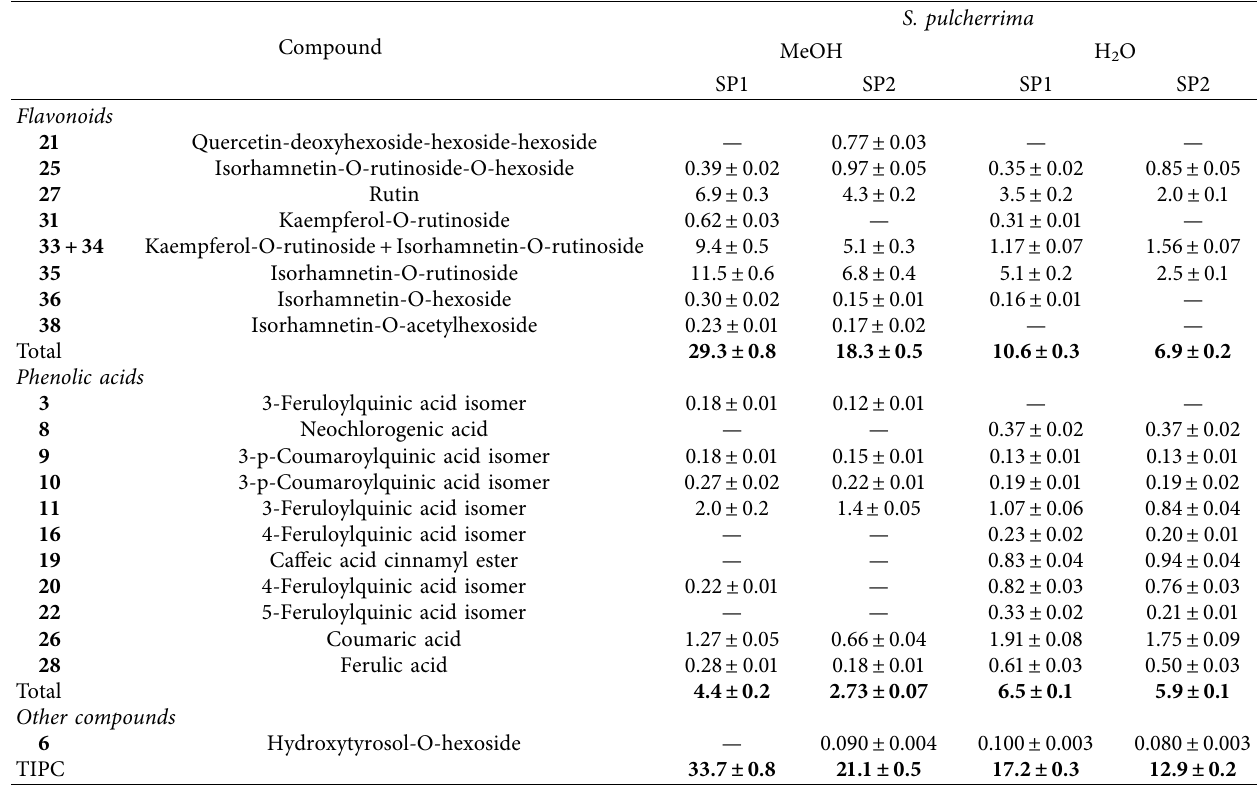
Table 4: Quantification of compounds in extracts of S. pulcherrima (SP) from two different locations, extracted in methanol and